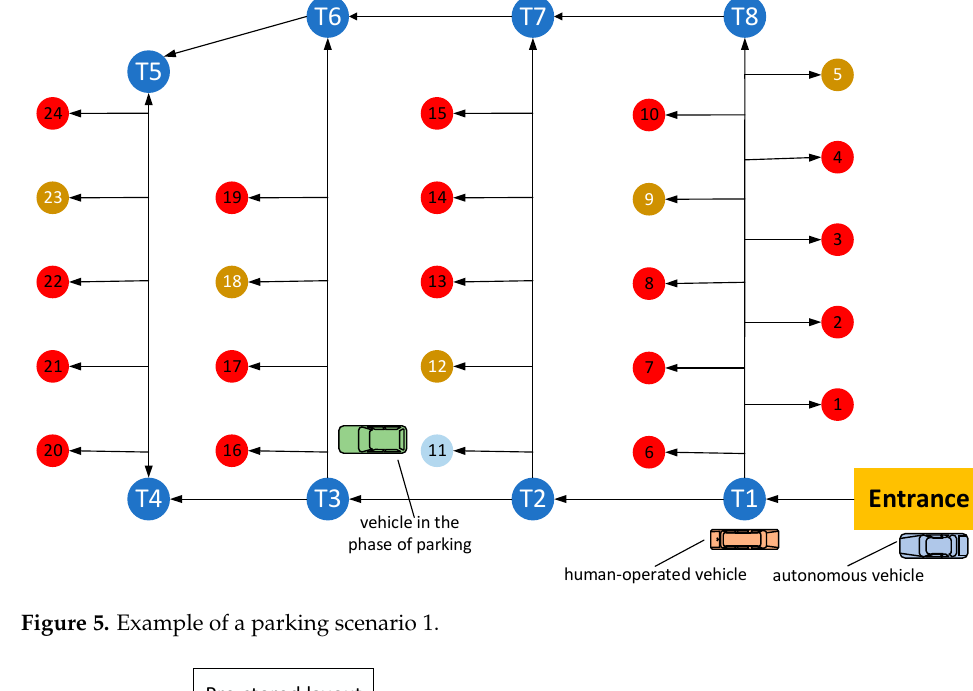
Table 2. Properties of the available parking spaces in the parking lot of scenario 1.